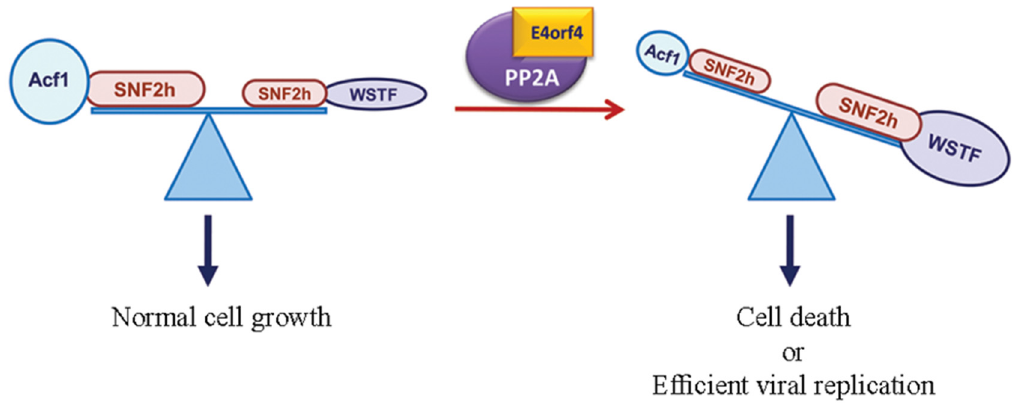
Figure 3. A working model of E4orf4 function in chromatin. Various SNF2h-containing complexes participate in chromatin remodeling and affect transcription, DNA replication, DNA repair, etc. The model shown in this figure proposes that E4orf4 together with PP2A inhibits the ACF chromatin remodeler. This inhibition leads to a shift in the balance between various SNF2h-containing remodeling complexes, allowing, for example, more activity of a WSTF-SNF2h complex. The variation in chromatin remodeling activity alters chromatin structure and induces changes in transcription, DNA replication, DNA repair, or other processes that require remodeling. These events contribute to E4orf4 functions during virus infection and lead to cell death when E4orf4 is expressed alone. This figure is adapted from [57] with permission of Oxford University